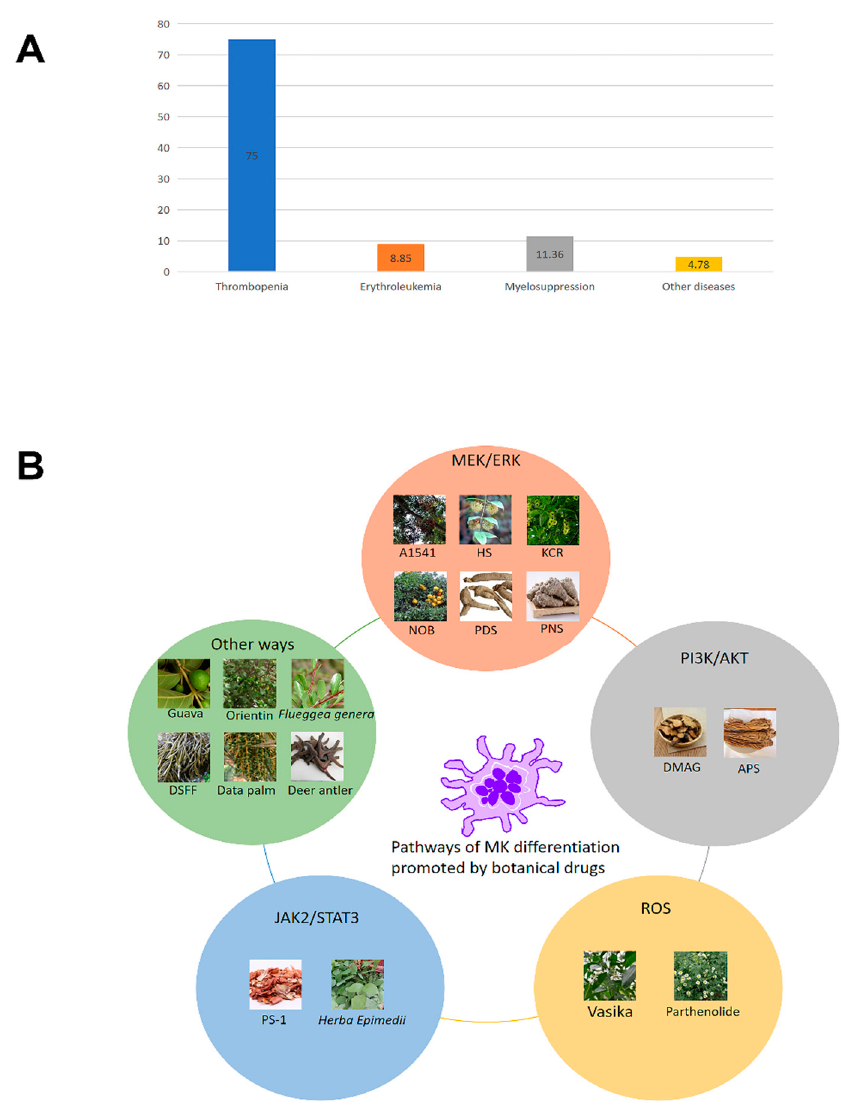
Figure 4. Diseases and molecular mechanisms of megakaryocyte differentiation. ( A ) The literature on some diseases of megakaryocyte differentiation searched in PubMed. ( B ) PDS, NOB, HS, A1541, PNS and KCR promote megakaryocyte differentiation by activating the MEK/ERK signaling pathway. DMAG and APS promote megakaryocyte differentiation by activating the PI3K/AKT signaling pathway. PS-1 and Herba Epimedii promote the proliferation and differentiation of megakaryocytes through the JAK2/STAT3 signaling pathway. Vasika and Parthenolide enhance mitochondrial permeability by promoting the generation of ROS. Some botanical drugs promote megakaryocyte differentiation in other ways. DSFF may promote megakaryocyte differentiation by increasing the level of TPO, and orientin promotes the differentiation of megakaryocytes by stimulating non-TPO sig- naling.